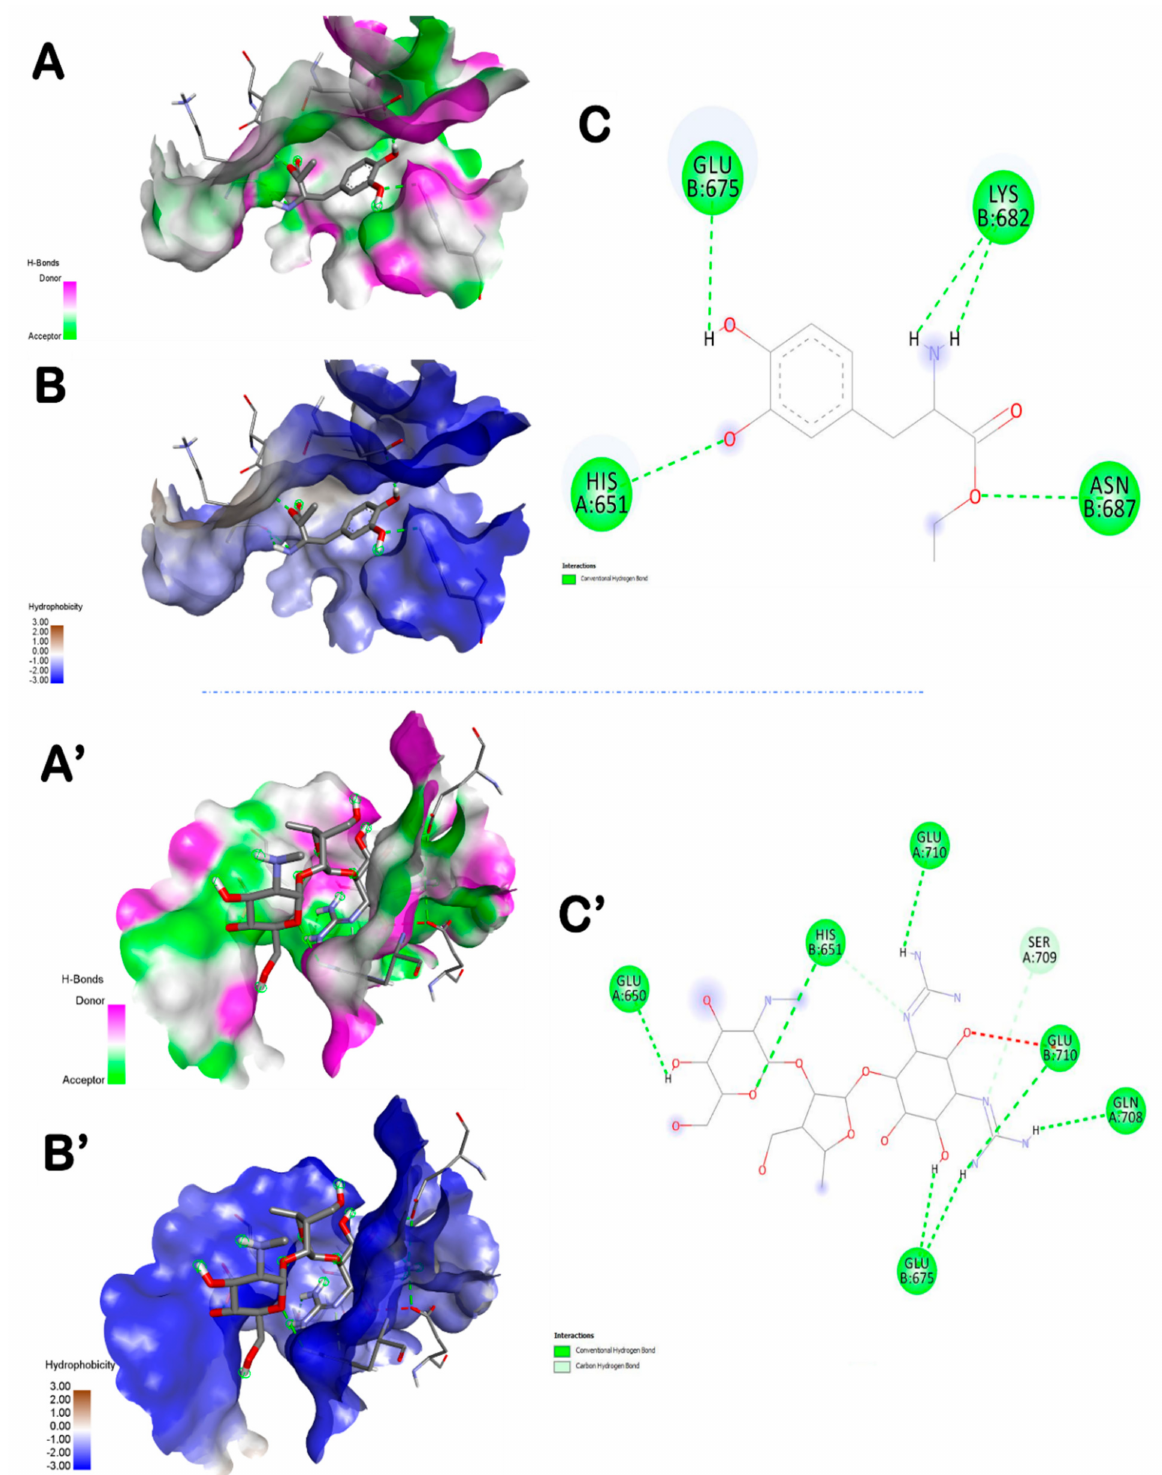
Figure 4. Representation of the 3D structure of AS compounds (L-4-hydroxy-3-methoxy-amethylphenylalanine ( A – C ) and dihydrodeoxystreptomycin ( A’ – C’ )), with the highest docking scores, bounded to the pocket region of TLR6. Micrographs of the pocket region with hydrogen bond ( A , A’ ) and hydrophobicity illustrations ( B , B’ ) and the corresponding 2D diagram of interactions ( C , C’